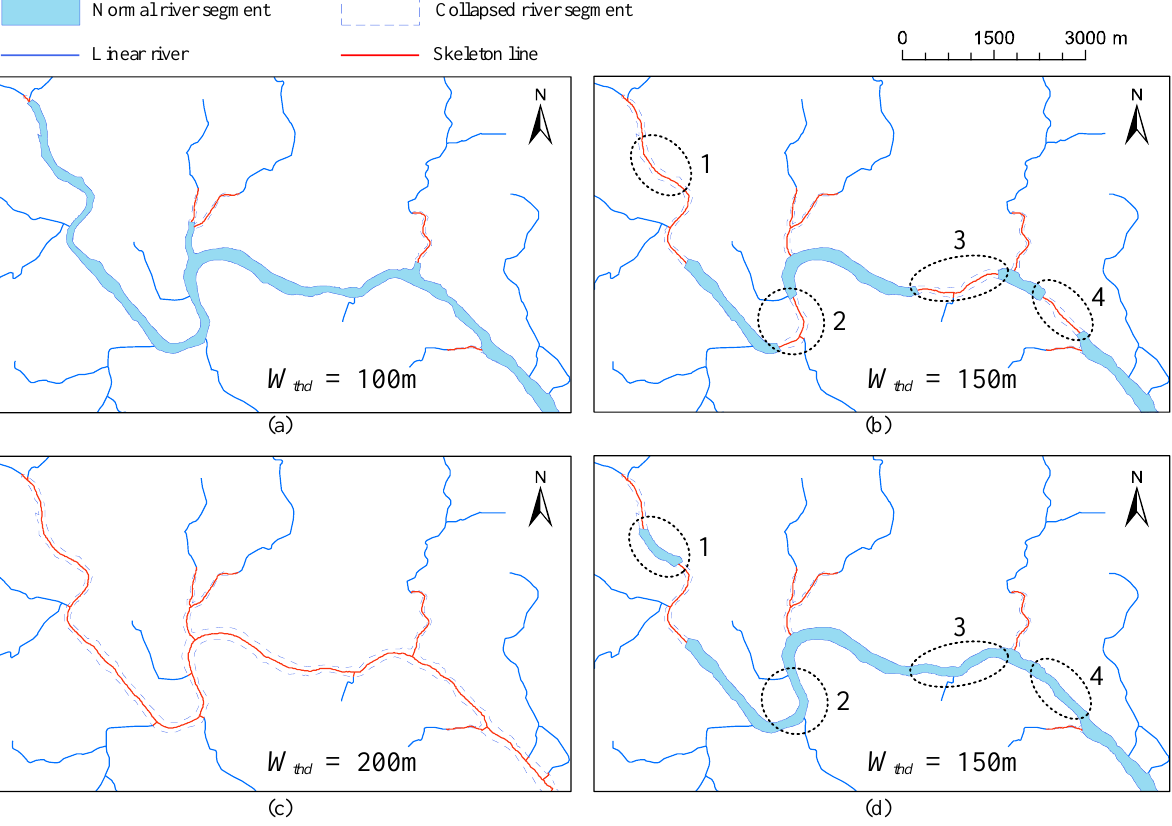
Figure 10. Progressive collapse results under the guidance of collapse priority strategy: ( a ) W thd = 100 m; ( b ) W thd = 150 m; ( c ) W thd = 200 m. Progressive collapse results under the guidance of exaggeration priority strategy: ( d ) W thd = 150 m